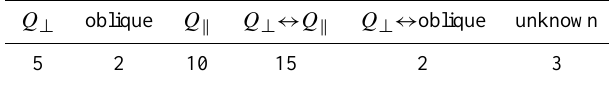
Table 1. Occurrence counts for embedding foreshock